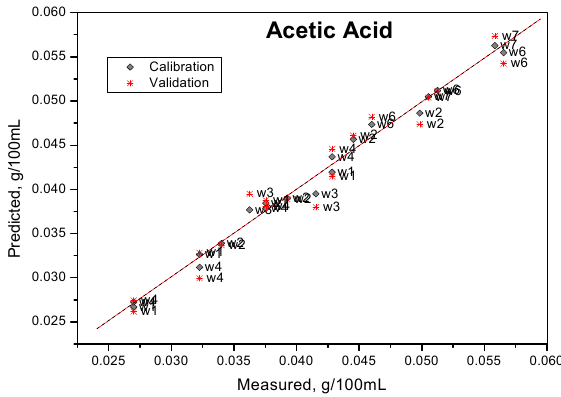
Figure 4. Acetic acid content in Verdicchio wines. Data treated by MLR, Calibration: Slope 0.9888, R 2 0.9943, RMSEC 0.000917, Validation: Slope 0.9857, R 2 0.9799, RMSEP 0.001743. The wines notations are the same as in Figure 3 caption. Table 3. The results of acetic acid prediction in Verdicchio wines.